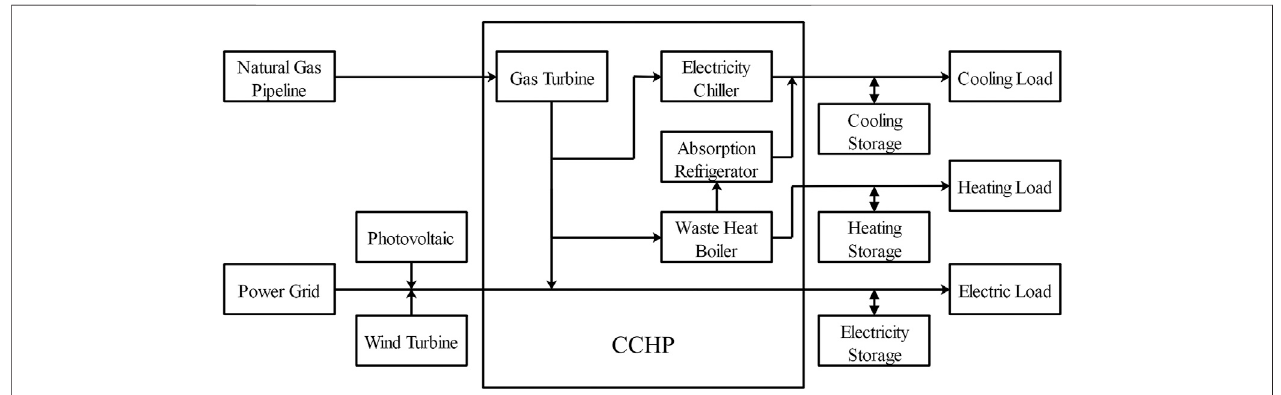
FIGURE 1 | Structure diagram of